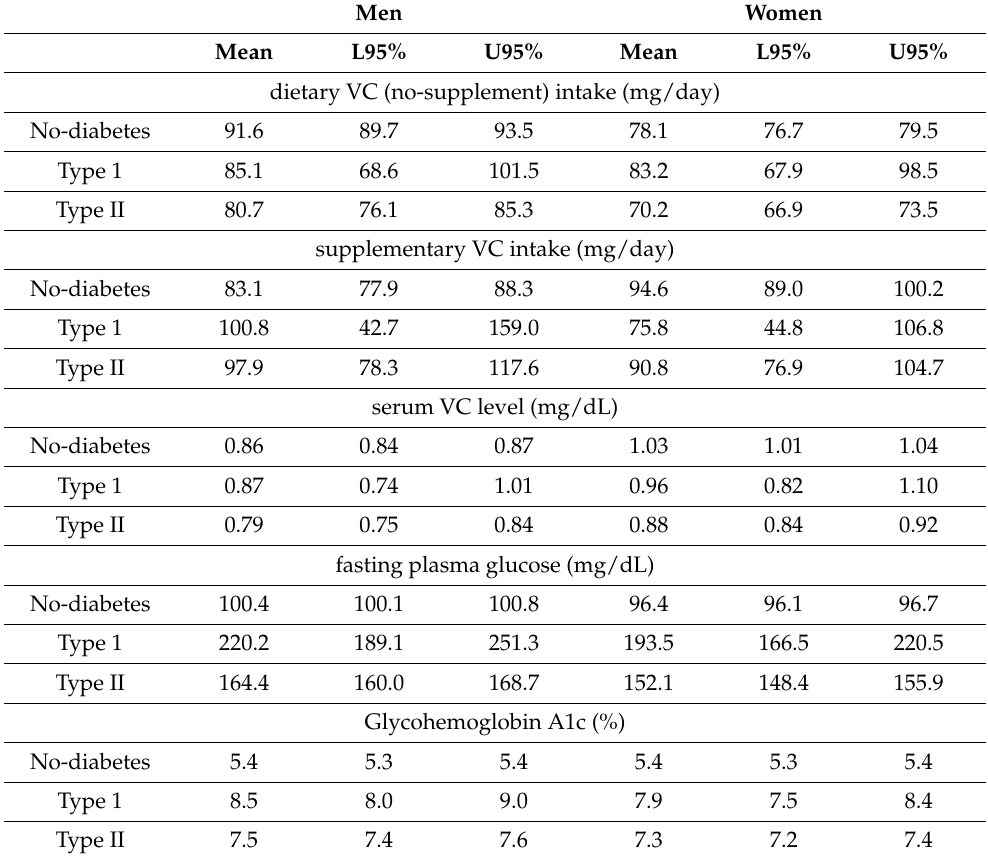
Table 2. Dietary VC and supplementary VC intake of people with type 1 and type 2 diabetes and without diabetes 1 .